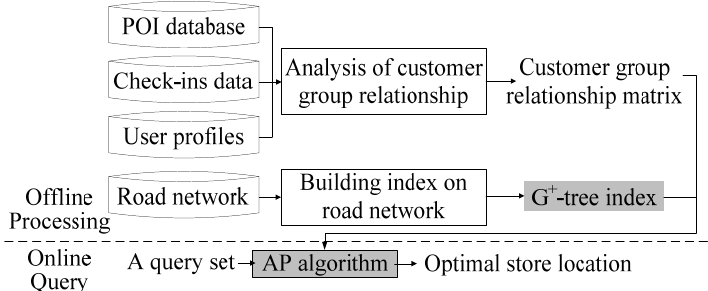
Figure 5. System framework of the AP algorithm.